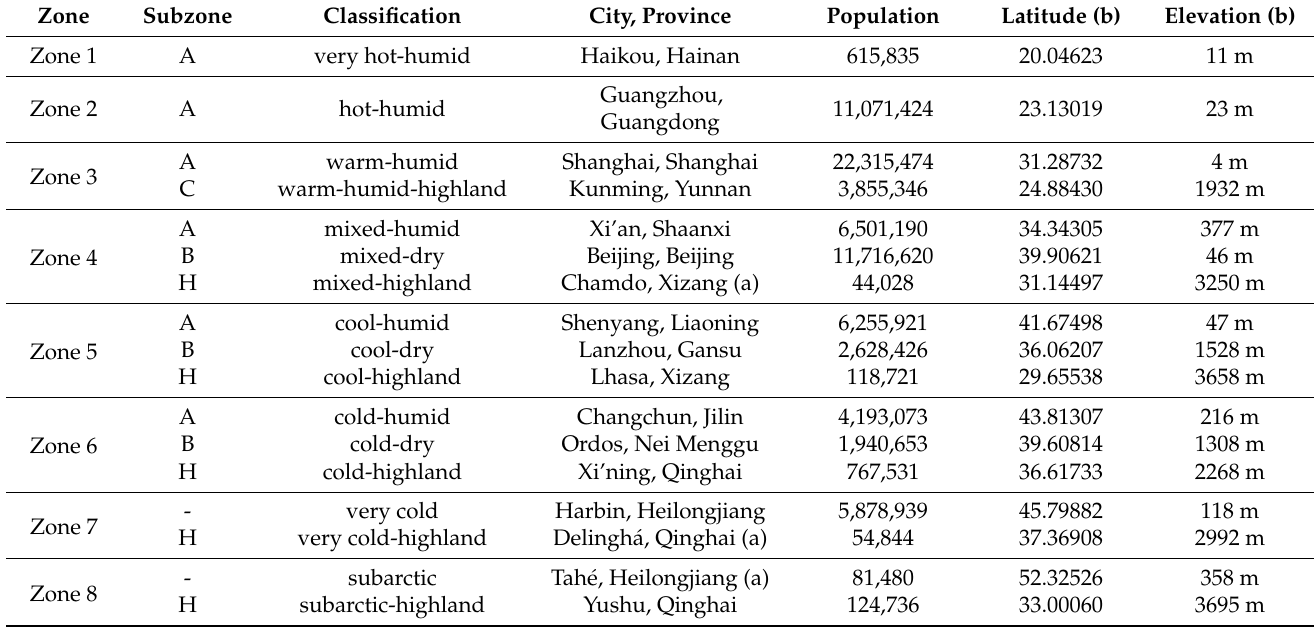
Table 6. Simulated location features per CZ according to Bai et al.’s ASHRAE classification [48] (p. 12),